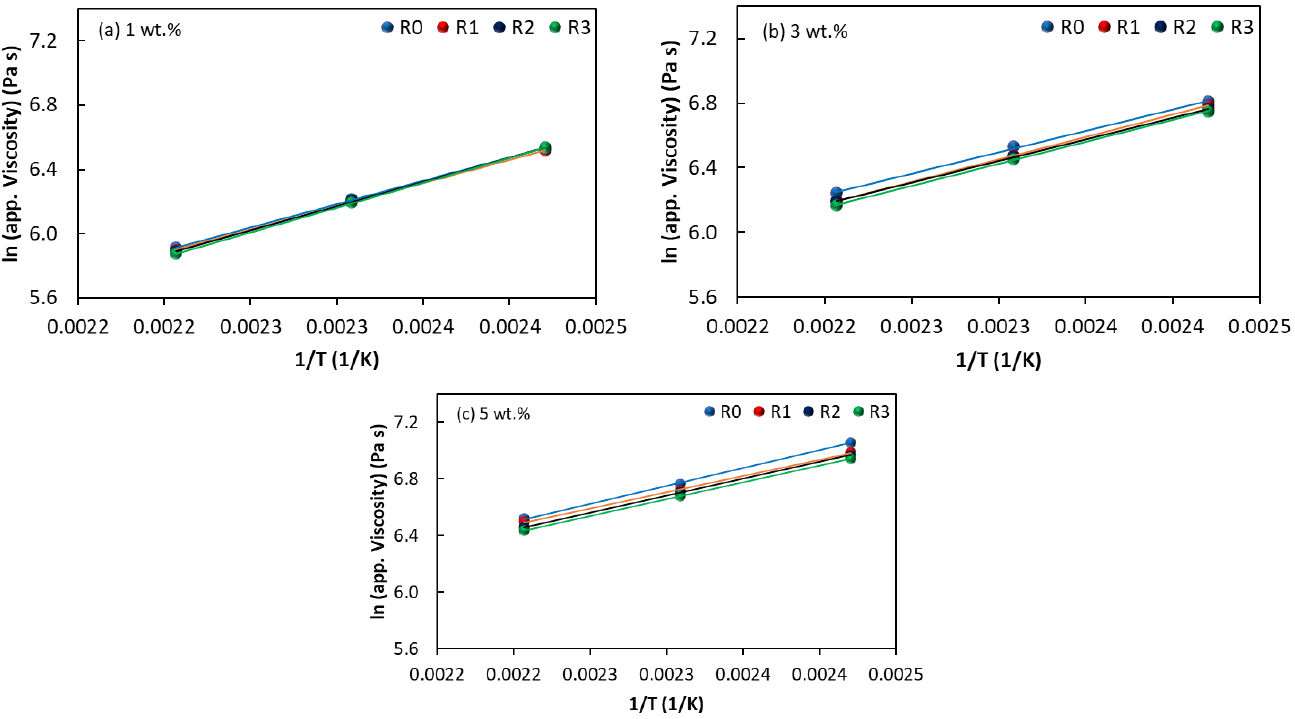
Figure 9. Influence of reprocessing on shear stress as a function of shear rate for the composites with ( a ) 1 wt.%, ( b ) 3 wt.% and ( c ) 5 wt.% of MWCNTs.